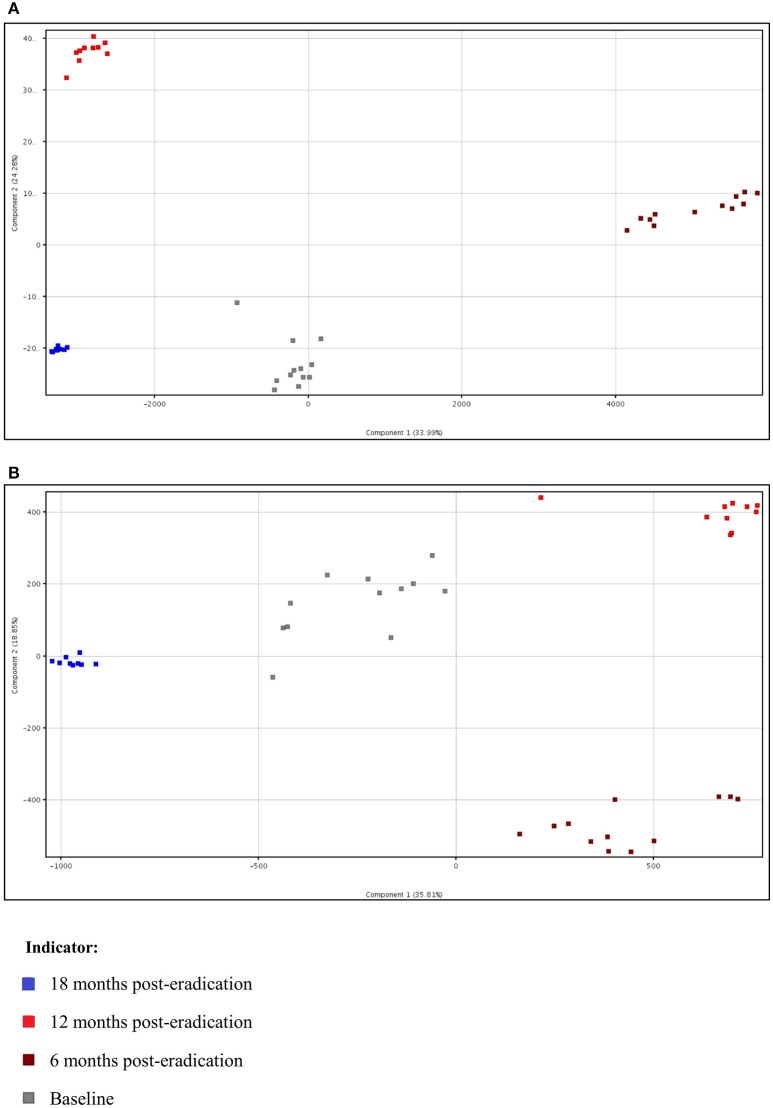
Two-dimensional PCA of plasma metabolomics for Baseline, 6 months, 12 months, and 18 months post-H. pylori eradication, acquired under both (A) positive and (B) negative ionization modes.